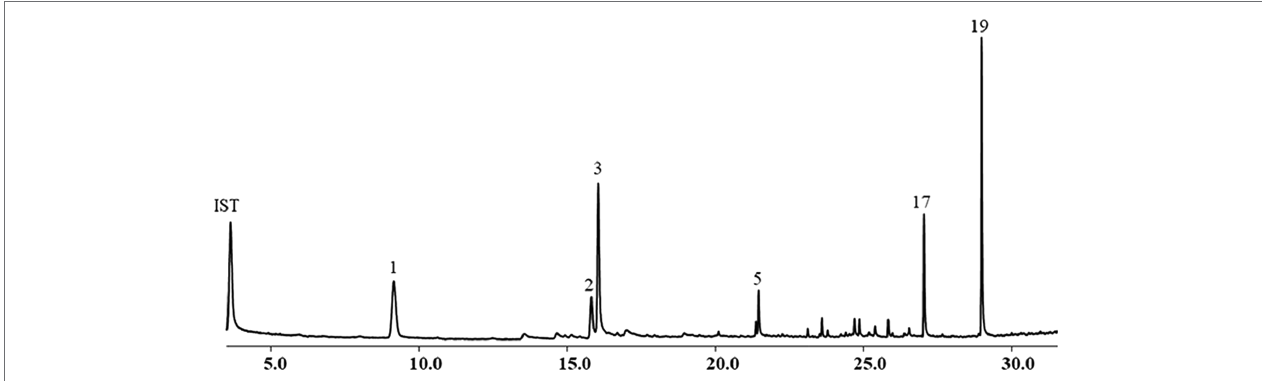
FIGURE 1 | Chemical composition of essential oils (EOs) from Artemisia nakaii analyzed using gas chromatograph-mass spectrometer. Nonane was used as an internal